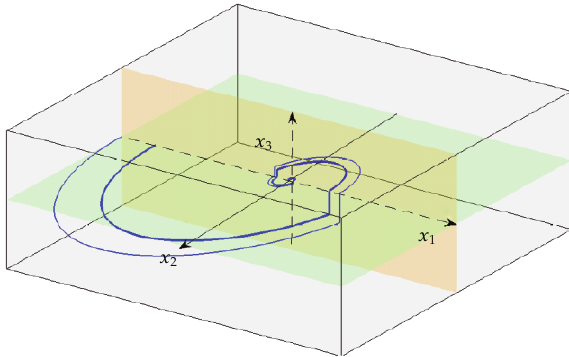
Figure 3: System solutions for the well-posed reset control system